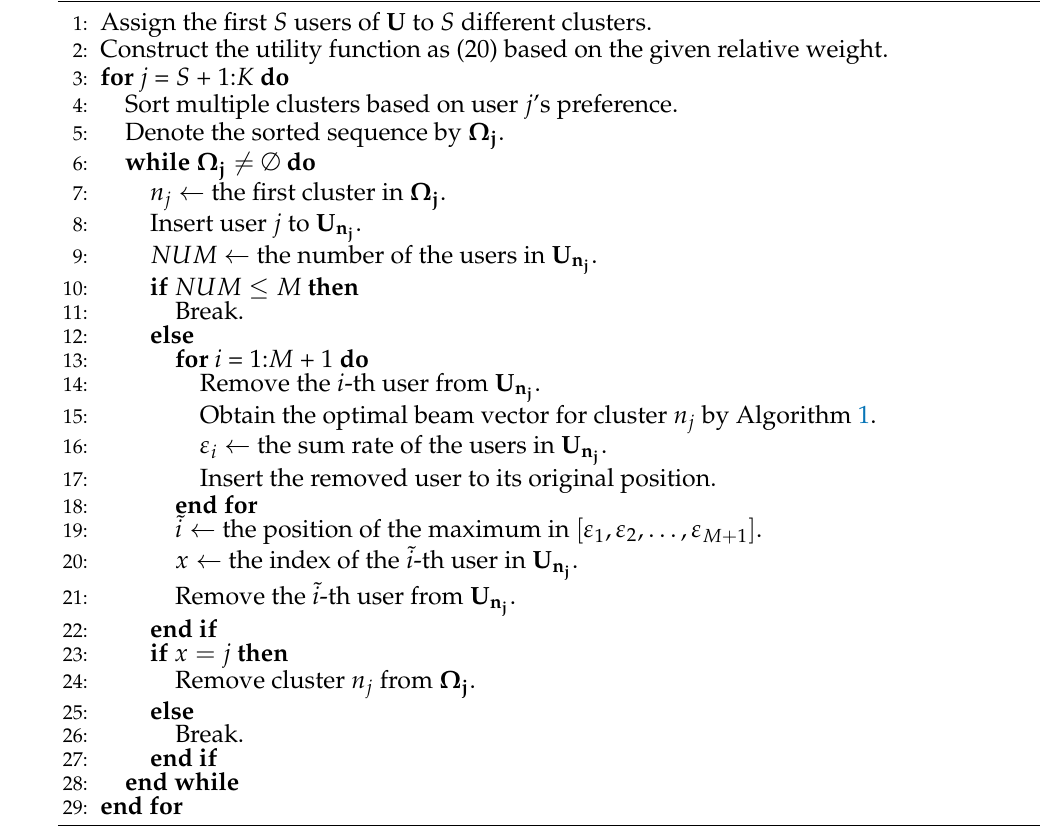
Algorithm 2 User Clustering Scheme for MIMO-NOMA with A Given Relative